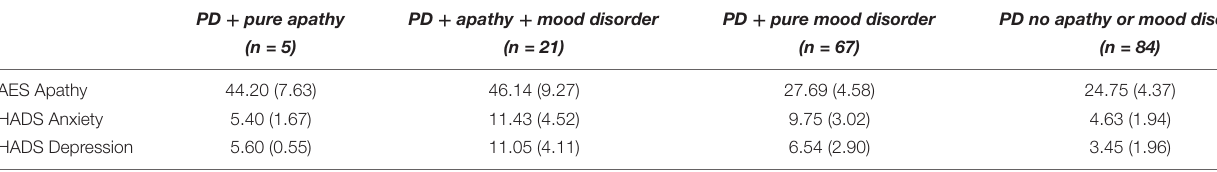
TABLE 1 | PD patients’ self-ratings of apathy, anxiety, and depression [mean (SD)].